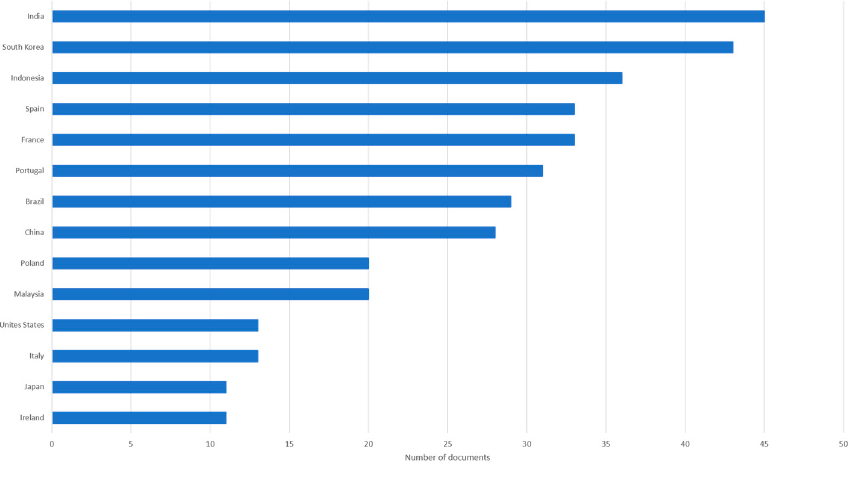
Figure 11. Documents by country or territory for cosmetics (Appendix